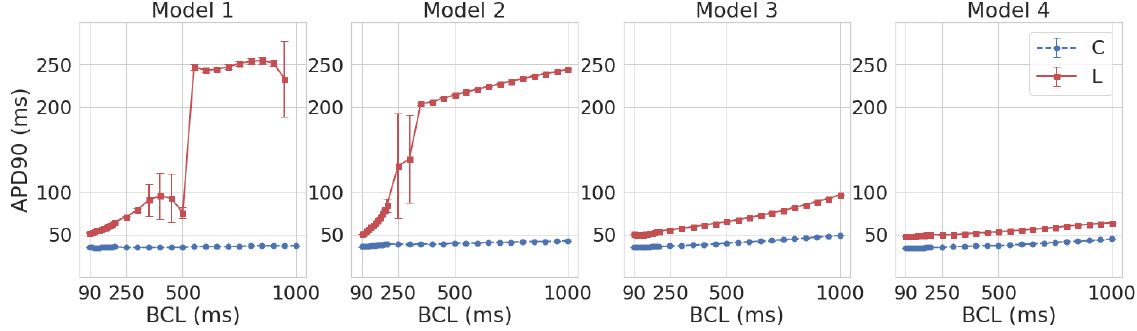
Figure 2. The APD90 restitution curves in Models 1–4 in the control (C, blue) and under leptin (L, red).